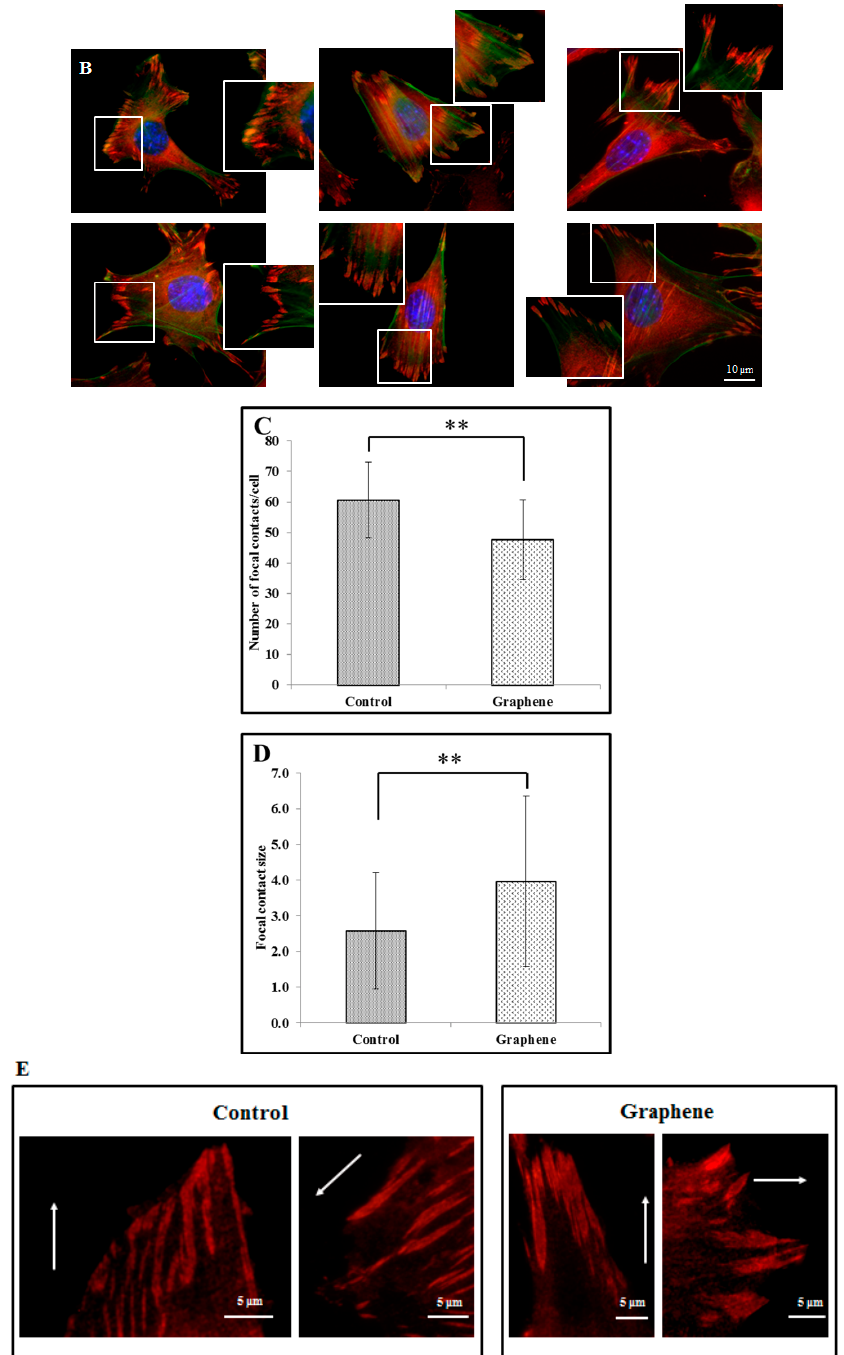
Figure 5. Focal contacts morphology of BALB 3T3 cells and calculation. Vinculin staining of focal contact on control ( A ) and graphene substrate ( B ). Focal contact number and size area of BALB 3T3 cells ( C , D ). Representative vinculin staining of attachment points (focal contacts) localized in lammelum area. The arrow indicates the direction of cell movement ( E ). Cells were stained with phalloidin-FITC (F-actin, green fluorescence), anti-vinculin Abs (vinculin, red fluorescence) and Hoechst 33,342 (DNA, blue fluorescence); Magnification in squares presents focal contacts and interaction between vinculin and actin. For focal contact number per cell at least 50 cells of each experiment were counted, and for focal contacts size, at least 10 areas of focal contacts per cell were analyzed. Data from three independent experiments are presented as mean ± SD (standard deviation). **-statistically significant